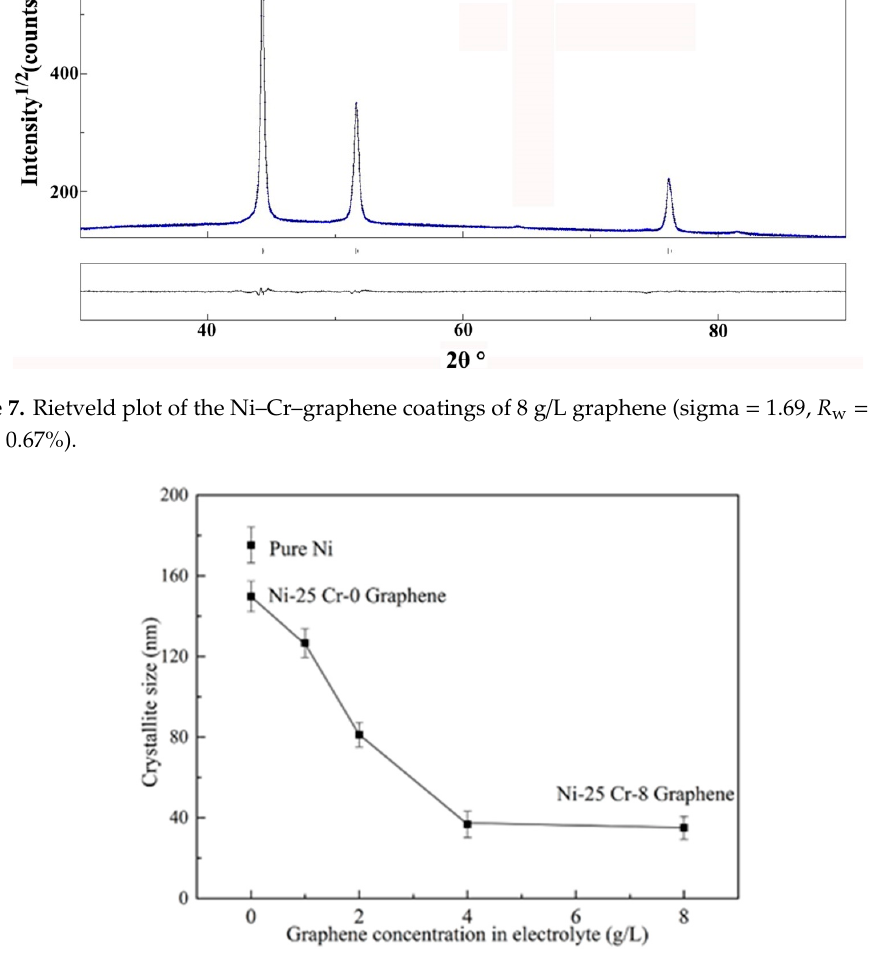
Figure 8. Crystallite size of Ni deposits in Ni–Cr–graphene coatings obtained from Rietveld refinements.